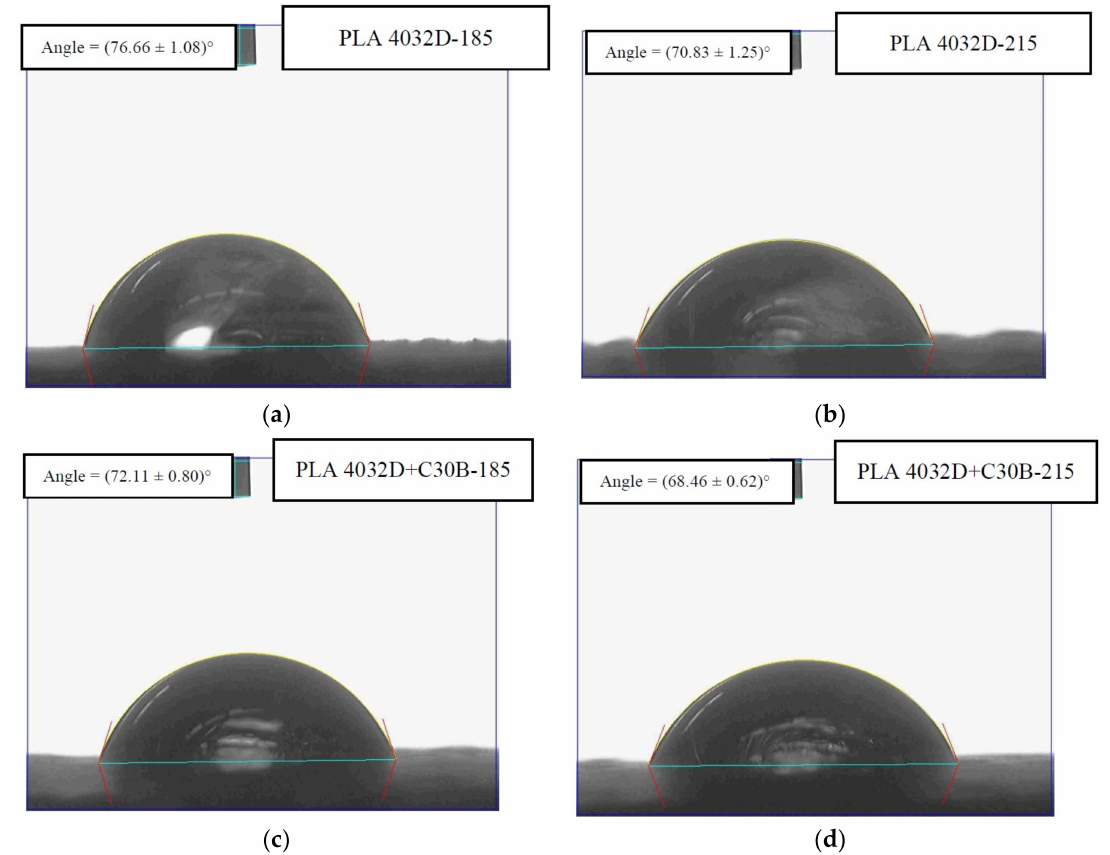
Figure 8. Contact angle of ( a ) PLA 4032D-185, ( b ) PLA 4032D-215, ( c ) PLA 4032D+C30B-185, ( d ) PLA